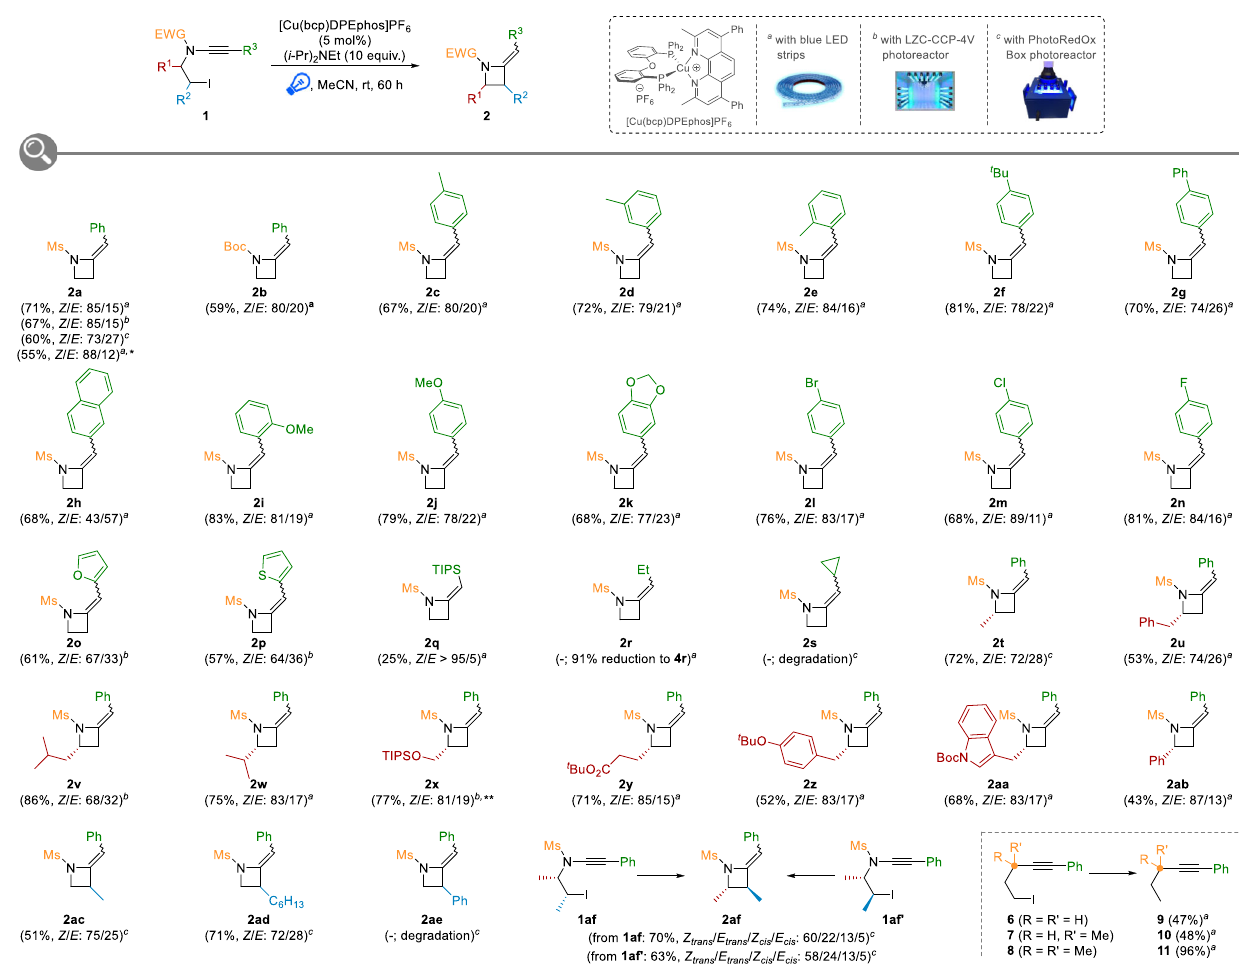
Fig. 3 Scope of the 4-exo-dig radical cyclization of ynamides to azetidines. Reaction conditions: ynamide 1 (0.2 mmol), [Cu(bcp)DPEphos]PF 6 (5 mol%), ( i -Pr) 2 NEt (2 mmol), MeCN (0.1 M), rt, 60 h. Isolated yields are provided and Z / E ratios were determined by 1 H NMR analyses of the crude reaction mixtures. * from N -bromoethyl-ynamide 1a Br . ** during 120